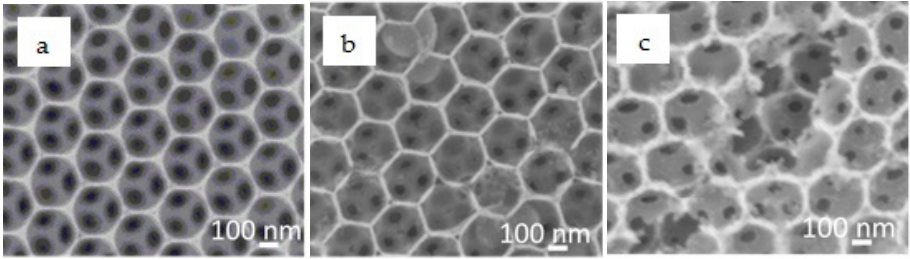
Figure 3. SEM images of inverse opal (IO)-TiO 2 without ZnS passivation ( a ); with 5 cycles of ZnS passivation ( b ); with 15 cycles of ZnS passivation ( c ).